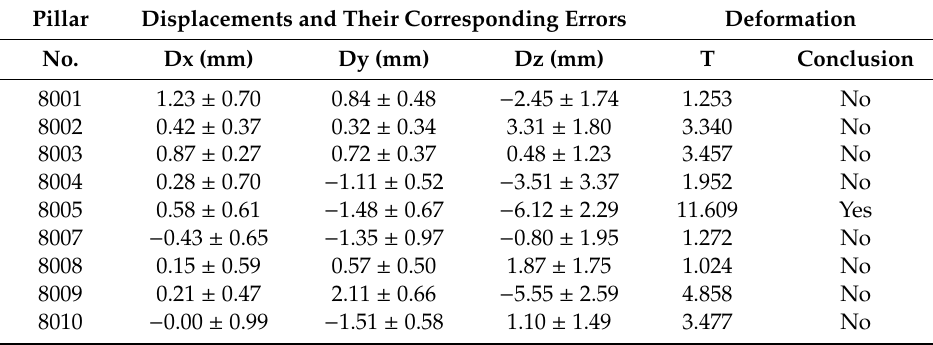
Table 1. Displacement of the reference frame pillars obtained by using sub-millimetric electronic distance meter (EDM) techniques between years 2018 and 2019. Points with statistical T above the cut-o ff value 5.739 are considered to have a significative displacement with a 99% probability. Pillar 8006 was not measured in the 2018 campaign. Pillar Displacements and Their Corresponding Errors Deformation No. Dx (mm) T Conclusion